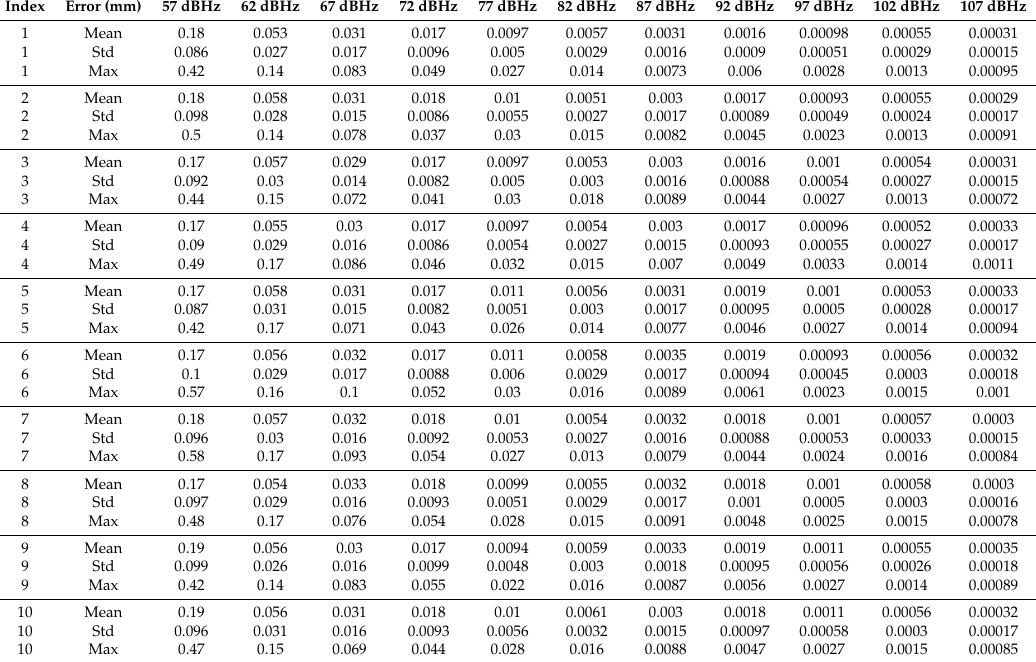
Table A1. Mean values, standard deviation, and maximum error values in the calculation of the impact point using FDMA with IQ with a 8-bit size.